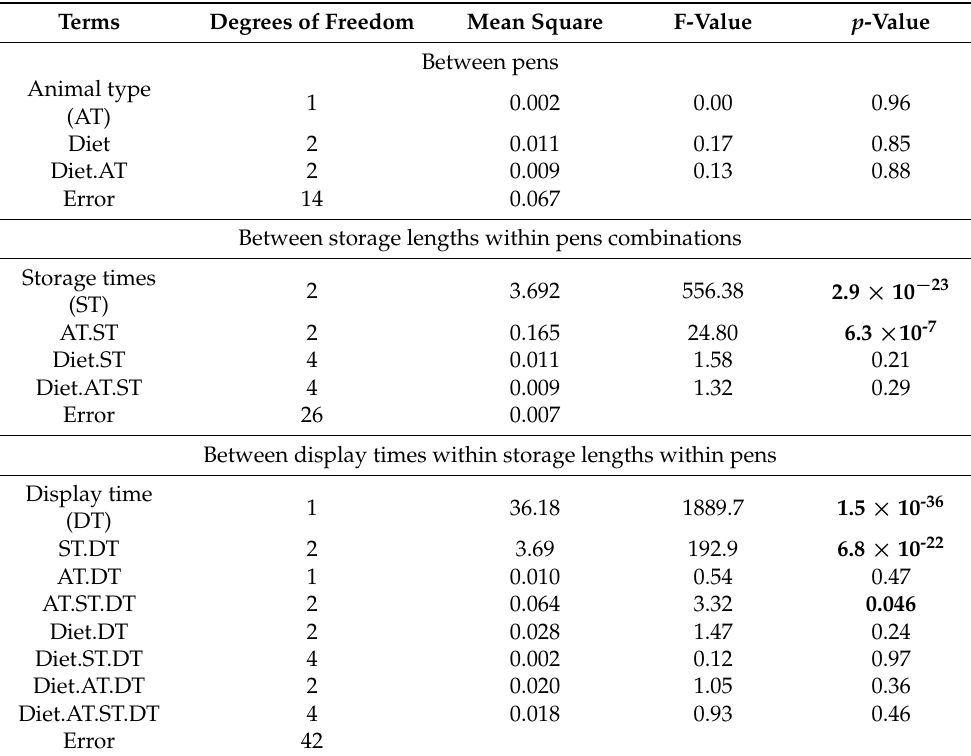
Table 4. Analysis of variance for the square root of TBARS of muscle longissimus lumborum subjected to different storage times (ST) and different display times